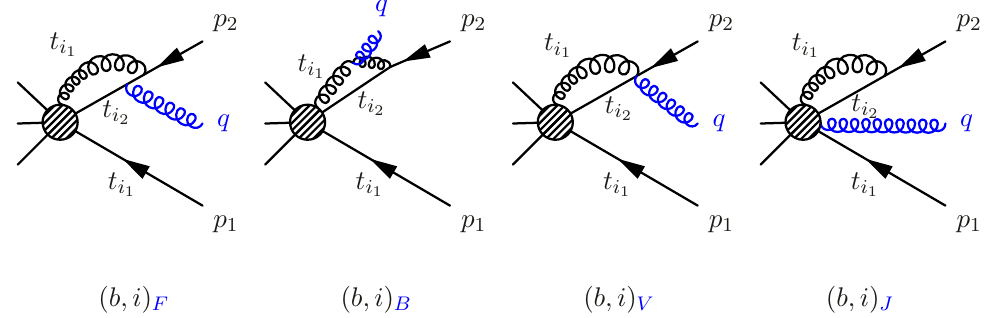
Figure 2 . Examples for the four possibilities of adding an extra collinear emission (indicated by the blue line) to a diagram with two fermion lines (chosen to be diagram ( b, i ) from figure 1. for